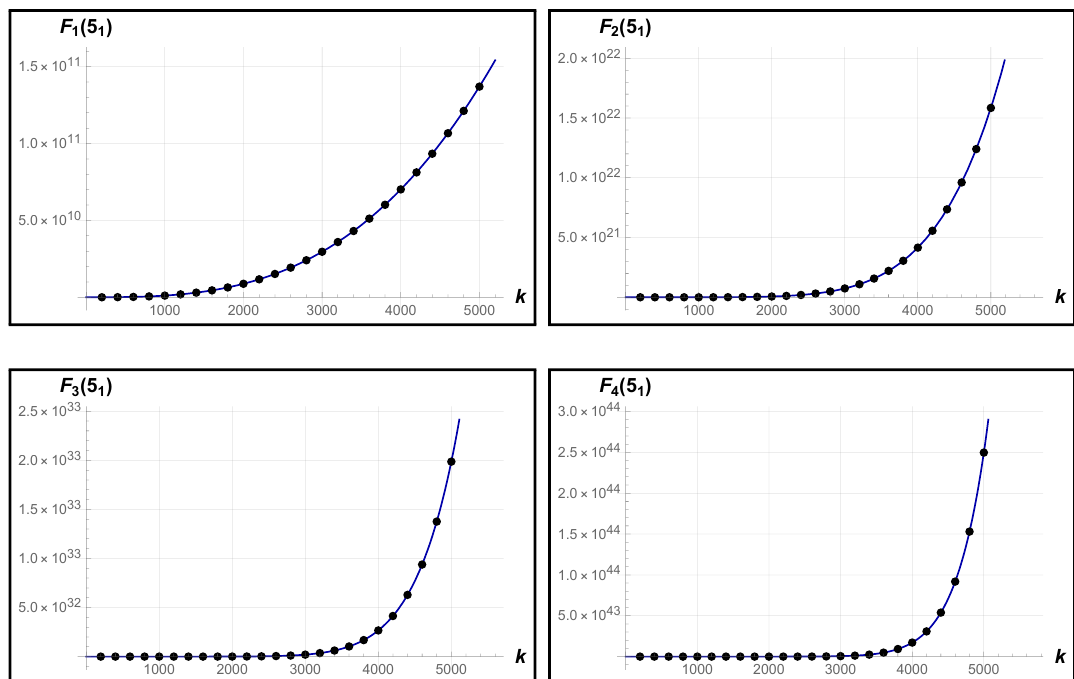
Figure 8. The variation of the function F m with k for 5 1 knot. The solid line denotes the function C m k 3 m with values of C m given in table 4. The • indicates the numerical values of F m obtained from explicit computations using